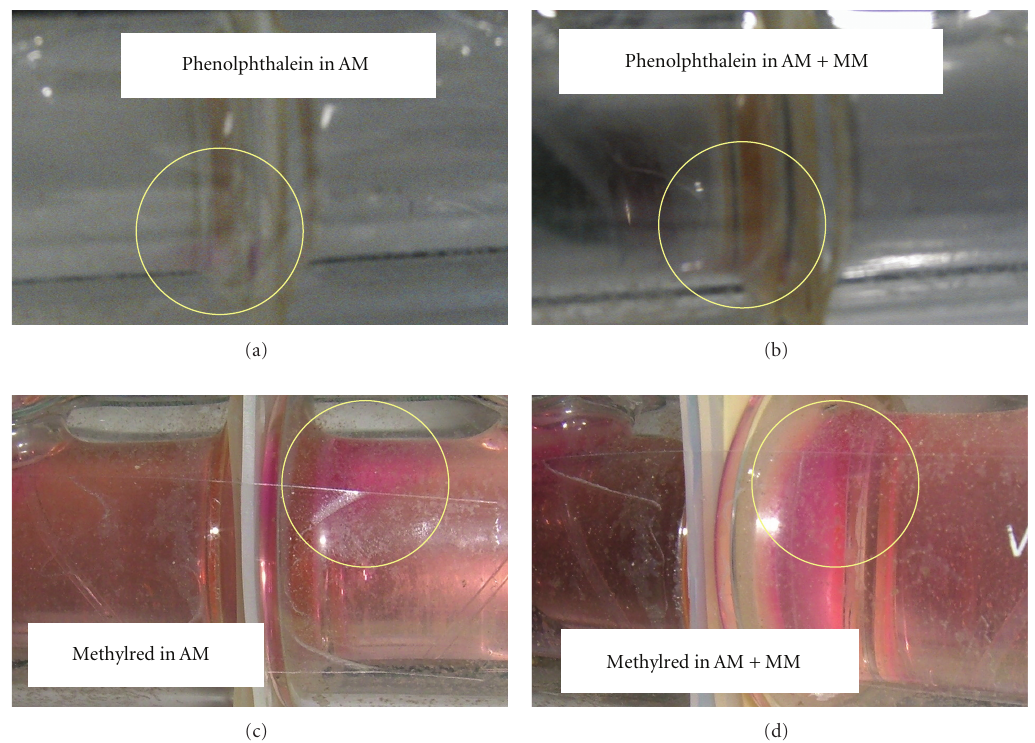
Figure 8: Indicator, methyl red in cell of two bottoms changed in red. This shows the existence of H + in a bulk solution.